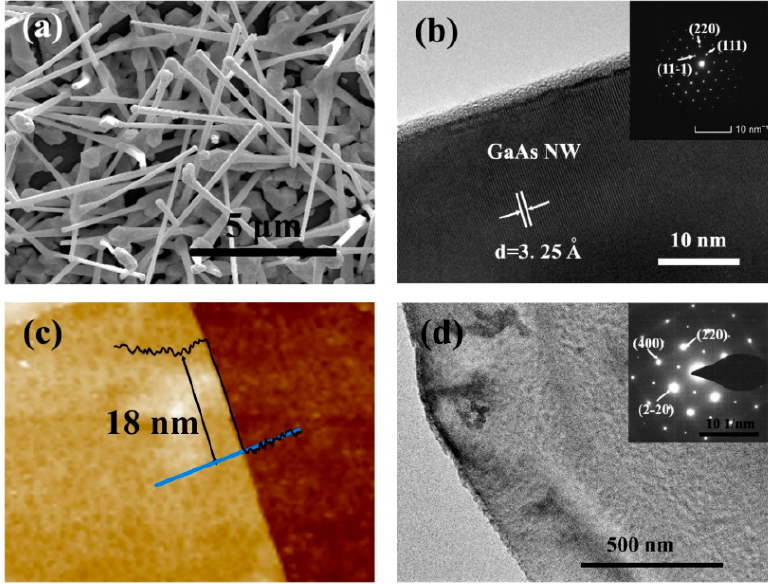
Figure 1. ( a ) Top-view SEM image of GaAs NWs, ( b ) TEM image of GaAs NW; the insert is the SAED ( c ) AFM image of GaAs 2DNLS, ( d ) TEM image of GaAs 2DNLS; the insert is the SAED of GaAs 2DNLS.